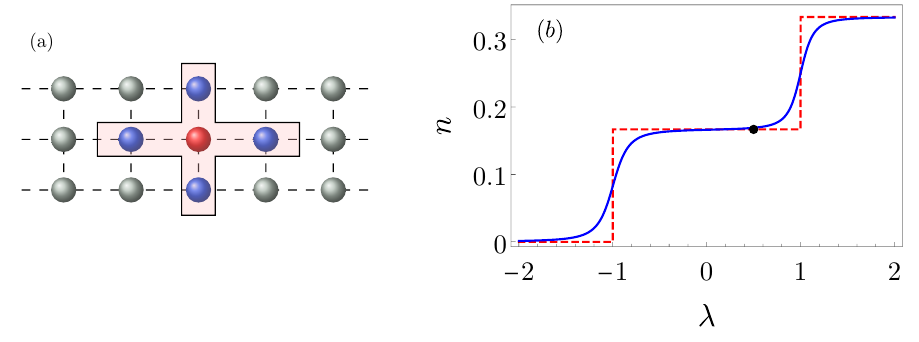
= 3 showing Figure 8: (a) Schematic representation of the Rydberg ladder for ℓ 0 the Rydberg blockade radius (rectangular region) around a Rydberg excitation (red circle). The blue circles denote sites with blocked Rydberg excitation. The black circle at λ ∼ 0.5 shows the position of the quantum phase transition.(b) The plot of = 3 leg ladder as a function of λ . The red dotted Rydberg excitation density n for a ℓ 0 line corresponds to w = 0 showing first order transition between the plateaus. The blue solid lines correspond to w = 0.05. The black circle shows the position of the quantum phase transition. All energies are scaled in units of ∆ . See text for